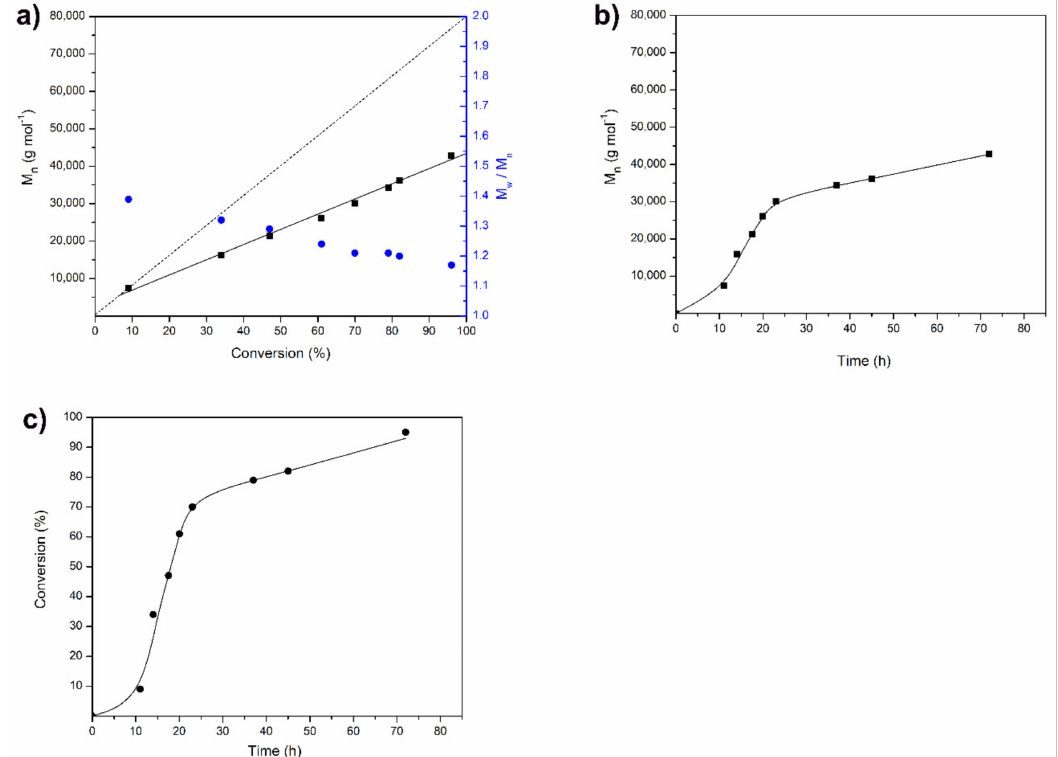
Figure 1. M n vs. conversion ( a ), M n vs. time ( b ) and conversion vs. time ( c ) kinetic plots for IBOMA RAFT polymerization (TCA as a solvent, CDTPA:AIBN = 4:1 by mol, [IBOMA] = 1.44 g mL − 1 or 50 wt%, M n theor = 50,000 g mol − 1